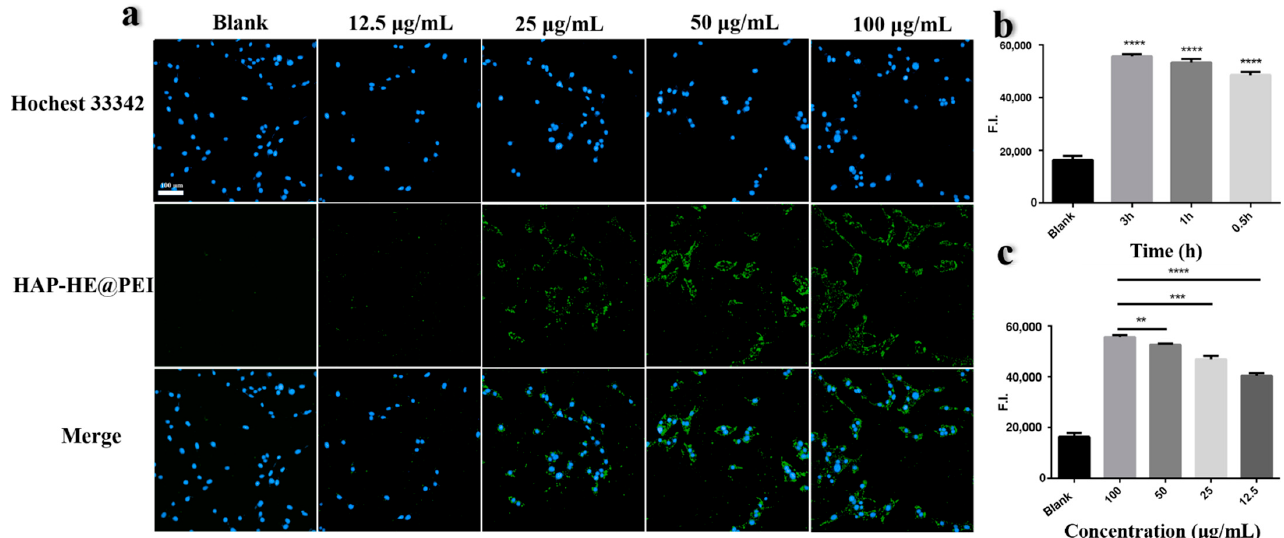
Figure 9. High-content imaging of HAP − HE@PEI. ( a ) Fluorescence images of NIH-3T3 cells co- incubated with different concentrations (12.5, 25, 50, 100 µ g/mL) of HAP-HE@PEI for 0.5 h detected by high-content imaging system. ( b ) Fluorescence intensity of HAP-HE@PEI and NIH-3T3 cells incubated with same concentration (100 µ g/mL) at different times (0.5, 1, 3 h). Values shown are mean ± S.D., **** p < 0.0001, vs. Blank group. ( c ) Fluorescence intensity of HAP-HE@PEI and NIH-3T3 cells incubated with different concentrations (12.5, 25, 50, 100 µ g/mL) at the same time (1 h) (HAP-HE@PEI: Ex = 440 nm, Em = 520 nm; Hoechst 33342 for nucleus: Ex = 346 nm, Em = 460 nm). Values shown are mean ± S.D., ** p < 0.01, *** p < 0.001, **** p < 0.0001, vs. 100 µ g/mL group, scale bar = 100 µ